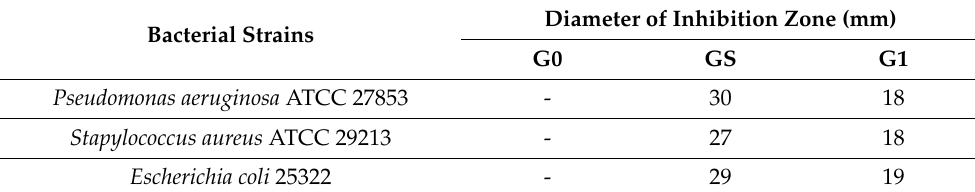
Table 3. Diameter of inhibition zone obtained by the diffusion method through spot inoculation for each type of tested